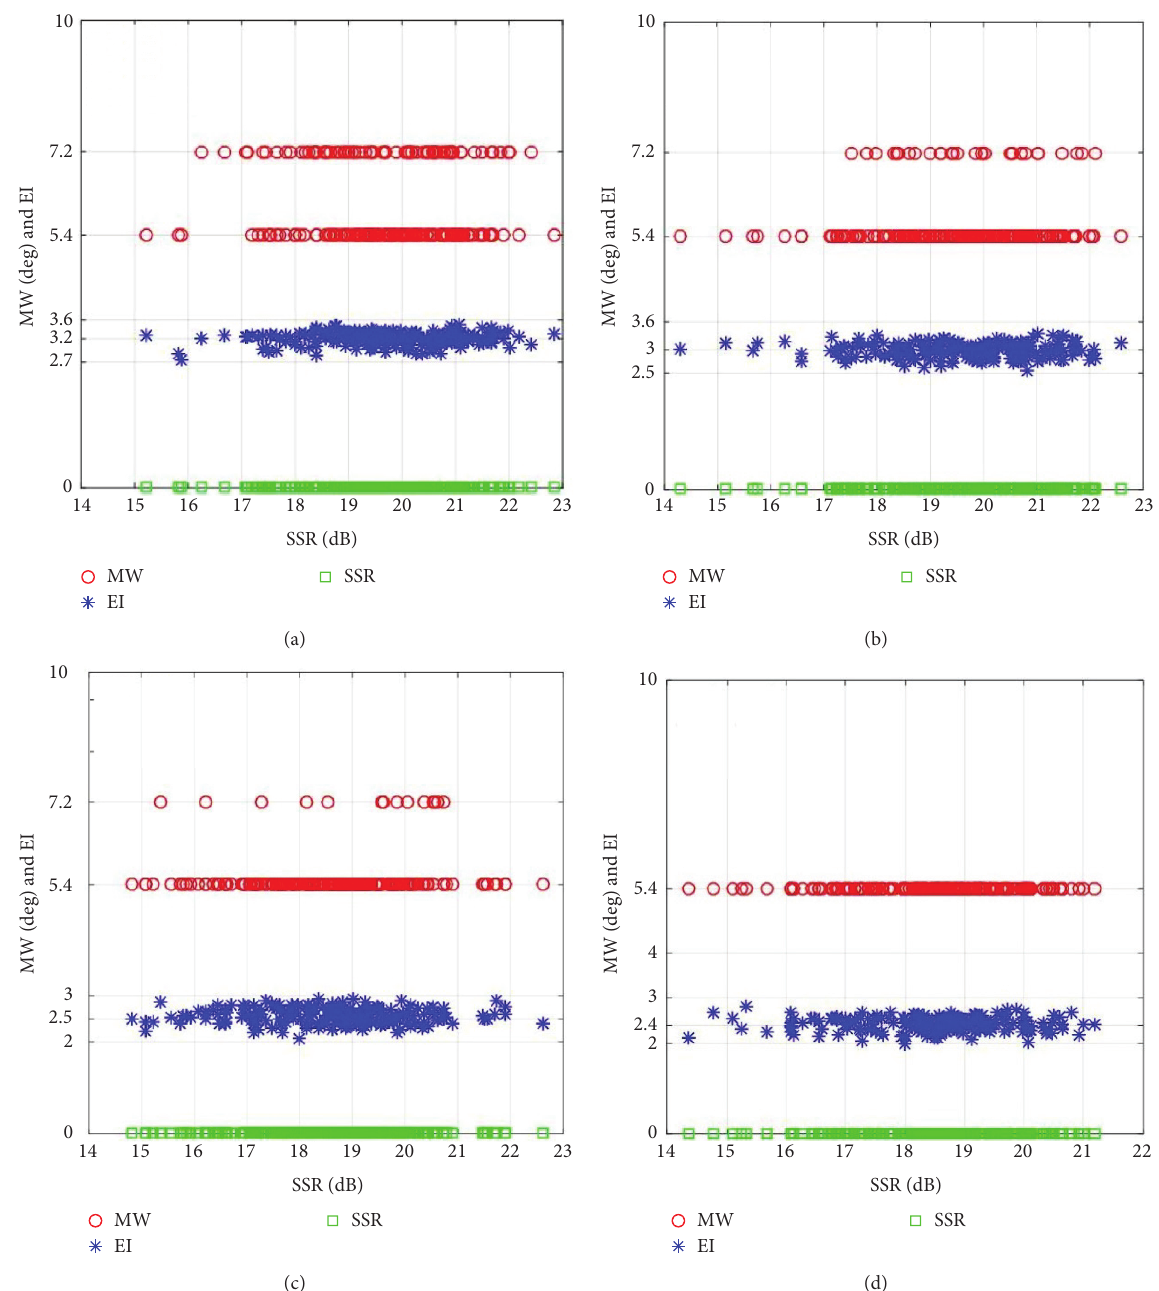
Figure 6: Evaluation of the partition array performance of four kinds of the partition configurations: (a) C � 7; (b) C � 9; (c) C � 8; (d) C �